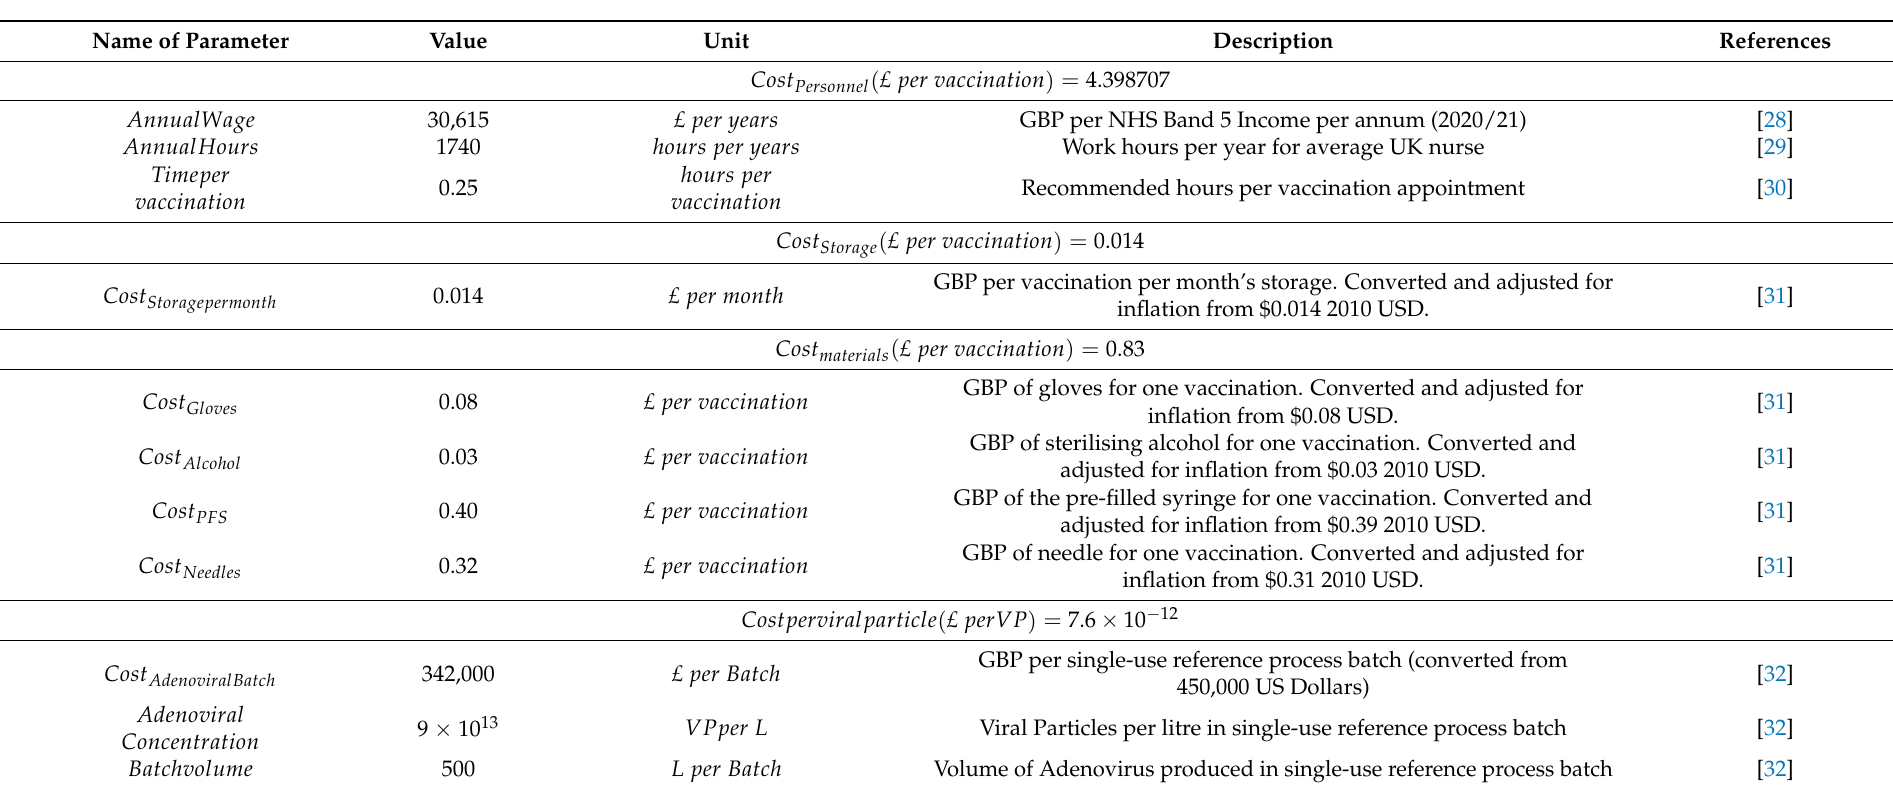
Table 2. Parameter values for the cost function. Where needed, a conversion rate of 0.78 U.S. Dollars per GBP was used [26], and a 10-year inflation rate was estimated as 1.35 2020 GBP per 2010 GBP Pound